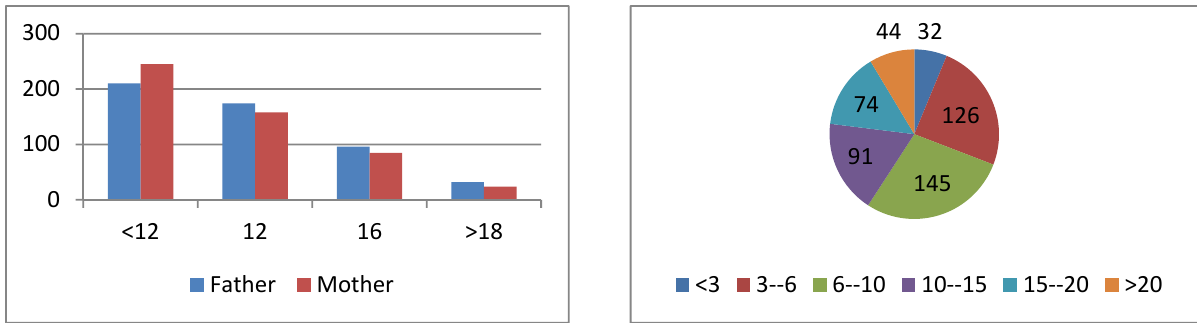
Fig. 1(a). Years of educational background Fig. 1(b). Average monthly income (million Rials) Fig. 1. Educational background of participants